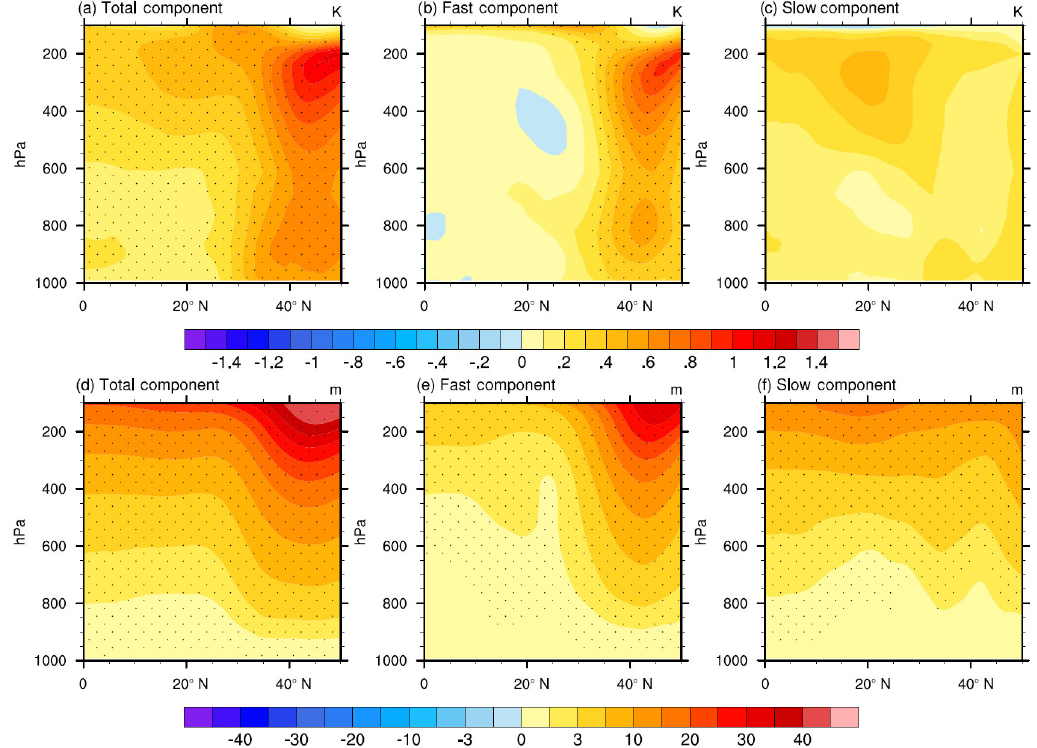
Figure 10. JJA mean total, fast, and slow responses of zonally averaged (a, b, c) atmospheric temperature (unit: K) and (d, e, f) geopotential height (unit: m) between 100 and 140 ◦ E to BC forcing. The dots represent significance at ≥ 95% confidence level from the t